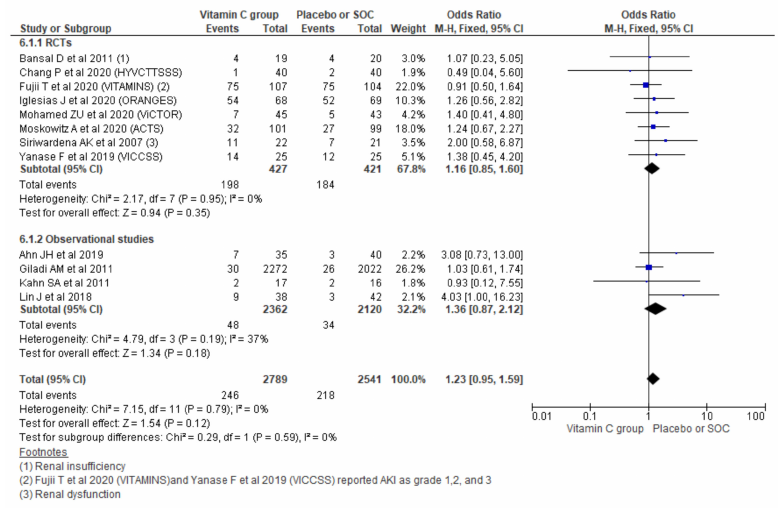
Figure 7. Forest plot showing the new occurrence of AKI using a fixed-effect model.